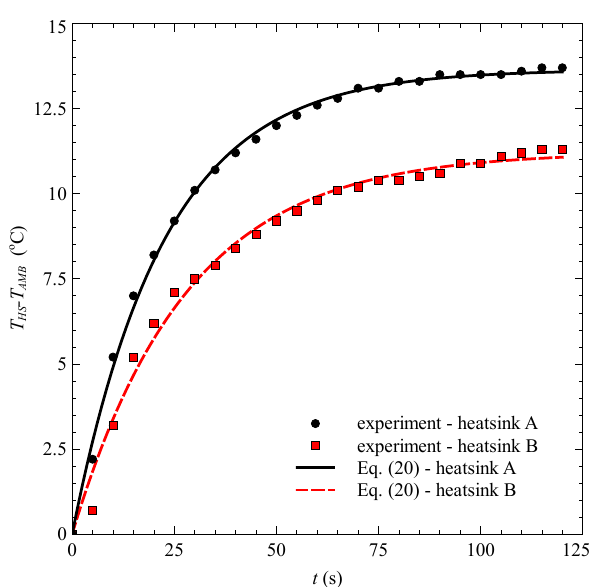
Figure 6. The temperature response of the heatsinks to applied temperature difference ∆ T = T HEAT − T AMB = 20 ◦